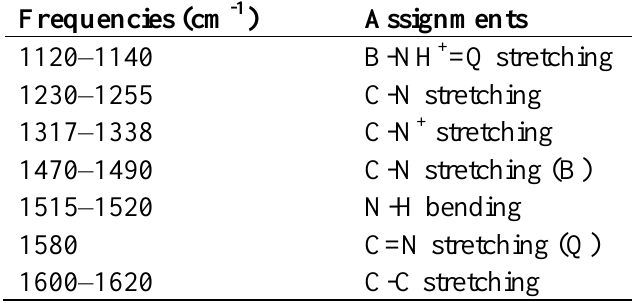
Table 1. Raman assignments of PANi bending and stretching bands.